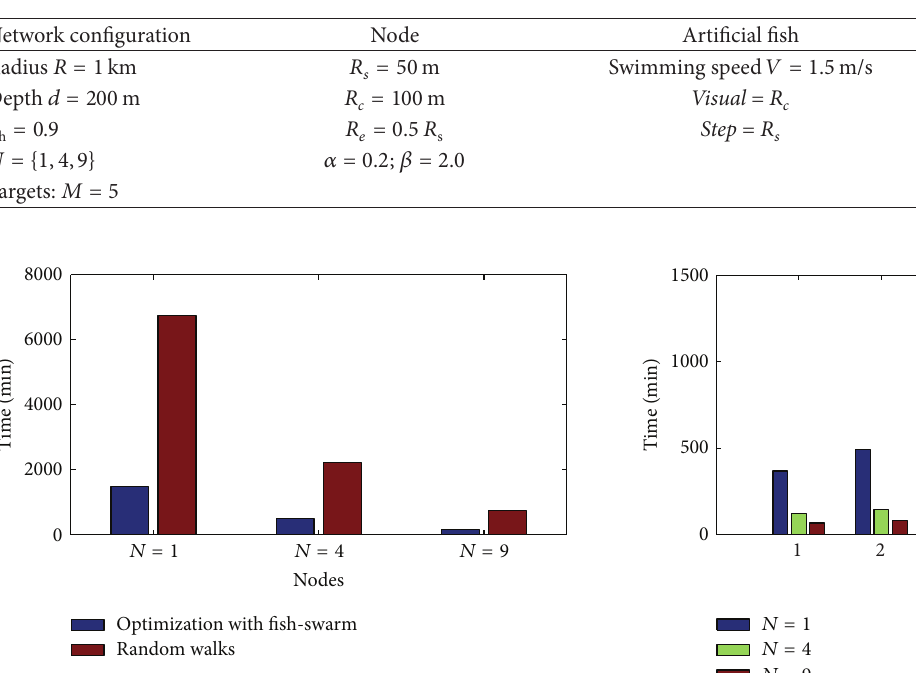
Table 1: Experiment parameters.